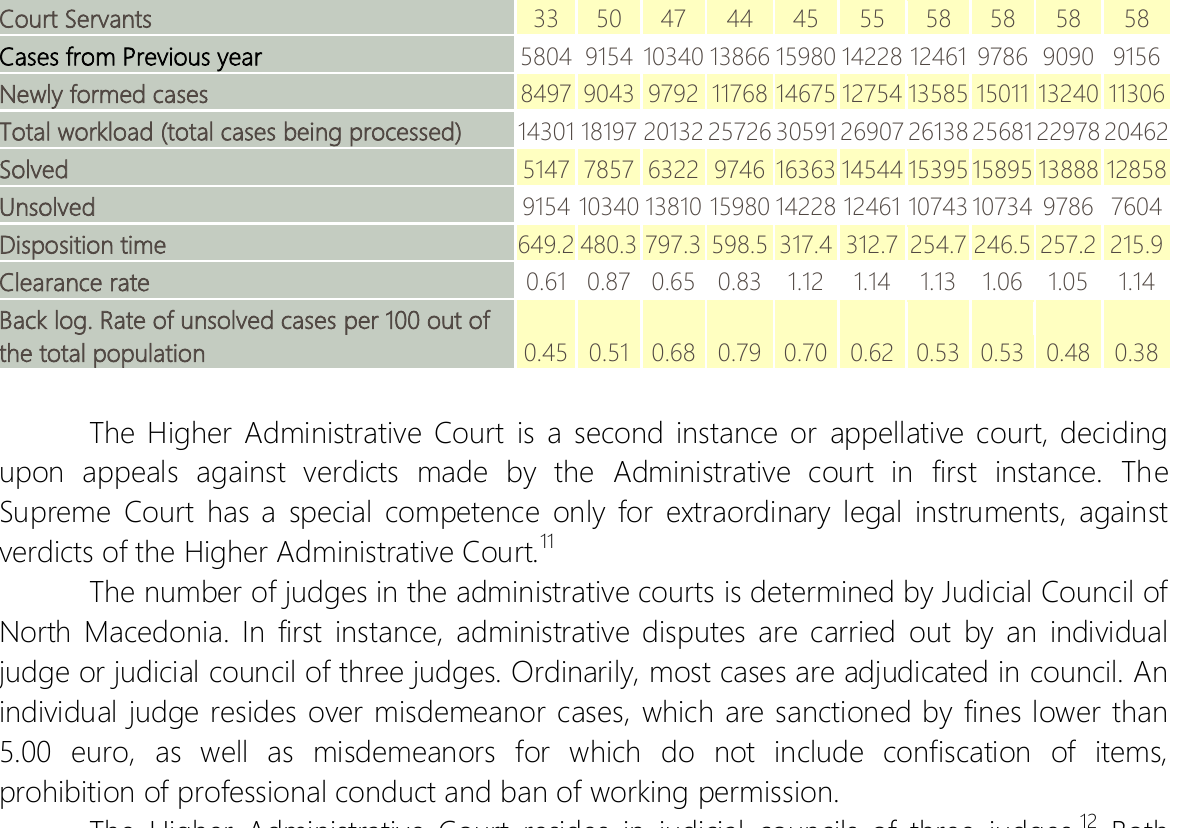
Table 5. Higher Administrative